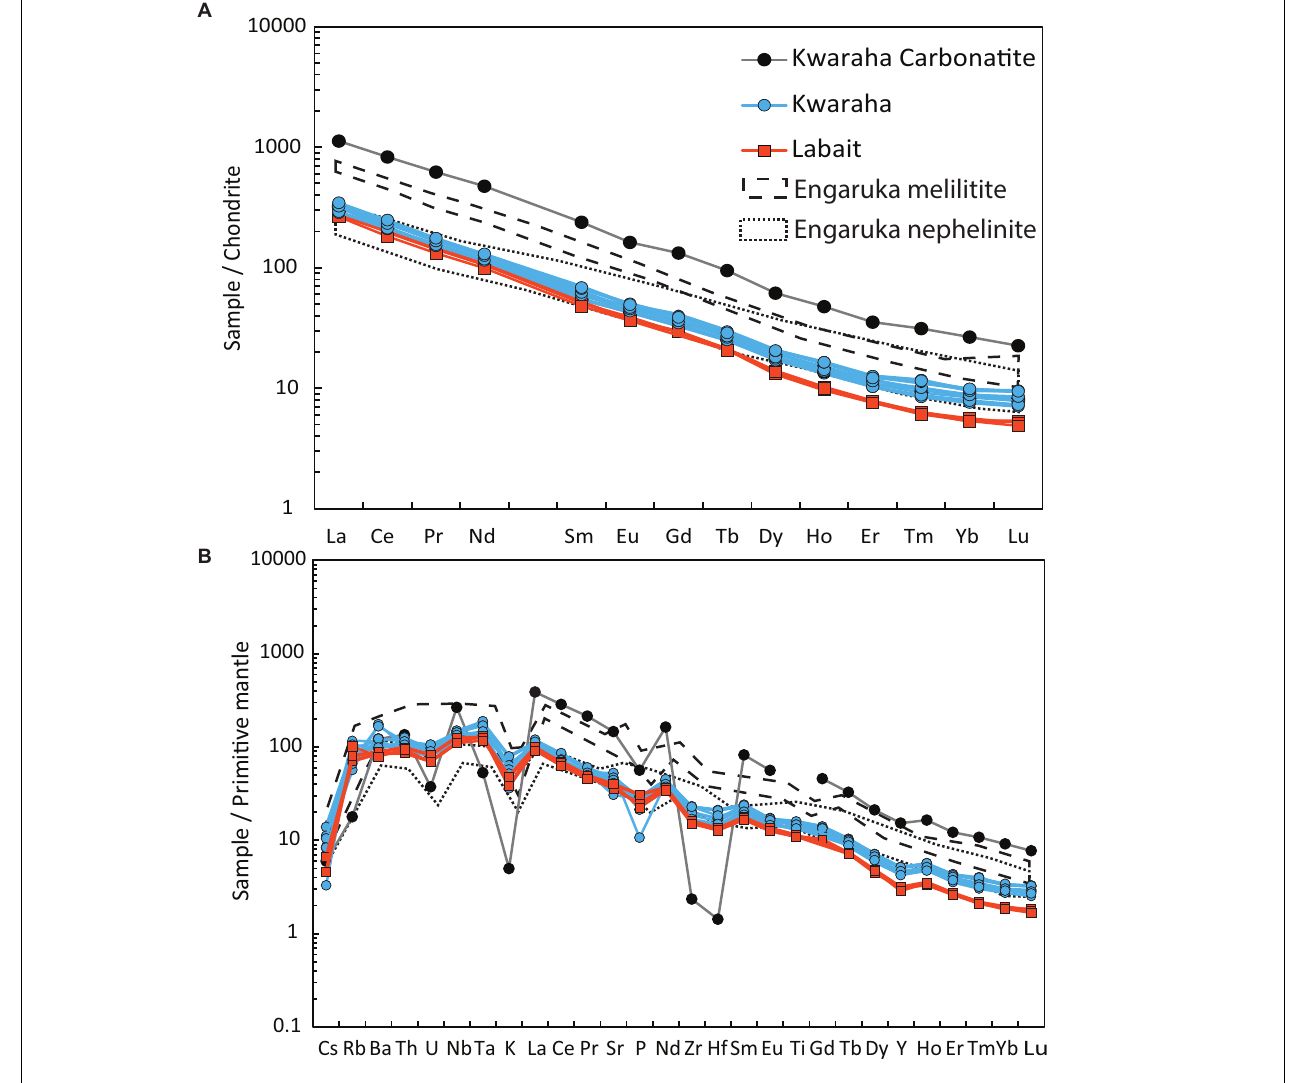
FIGURE 8 | (A) Chondrite-normalized REE contents and (B) primitive mantle-normalized trace element compositions of Kwaraha and Labait nephelinites (symbols as in Figures 3 , 4 ) and the Kwaraha carbonatite (black circles). Primitive mantle and chondrite values from Sun and McDonough (1989). Engaruka melilitites and Engaruka nephelinites from Mattsson et al. (2013) are also